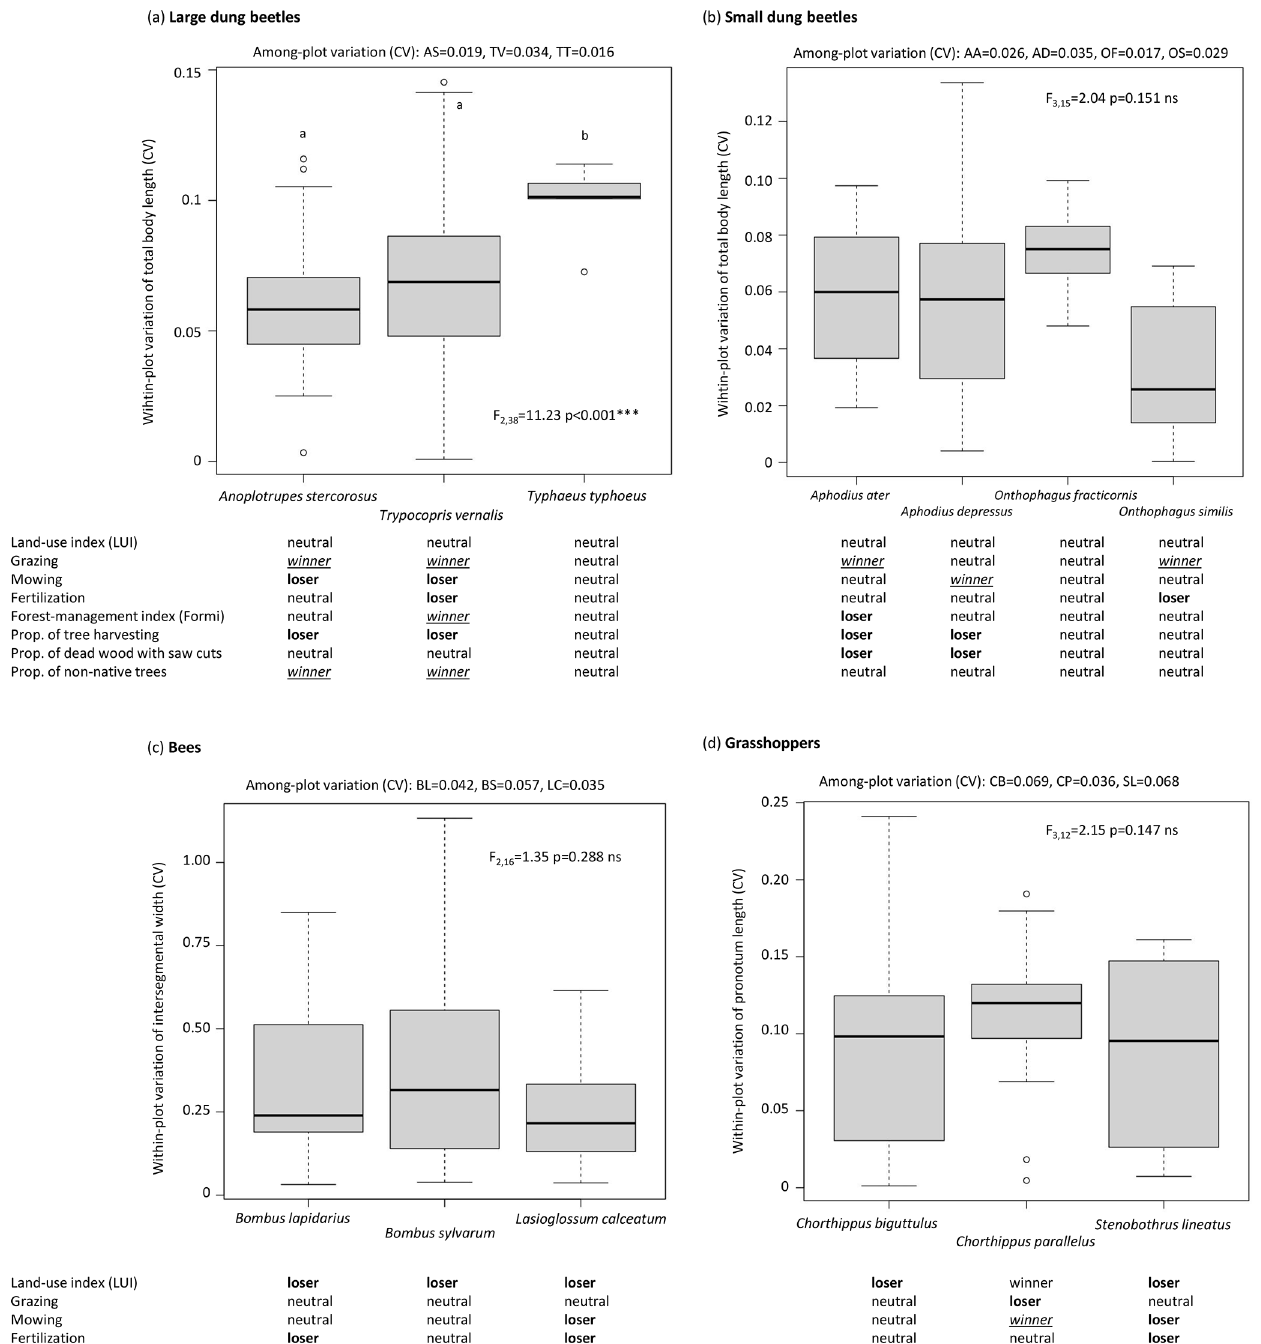
Figure 1. Differences in within-plot variation of body-size traits in (a) large dung beetles, (b) small dung beetles, (c) bees, and (d) grasshop- pers. Among-plot variation is shown above the plots, the species’ status to the respective land-use component underneath. Note the different scales. Abbreviations: CV – coefficient of variation, ns – not significant ( p > 0.05), ∗ = p ≤ 0.05, ∗∗∗ = p ≤